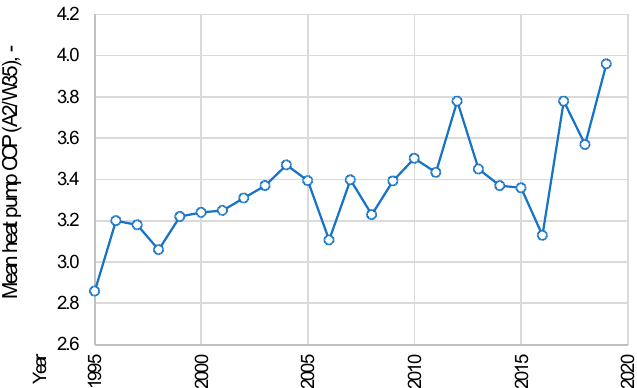
Figure 6. Variability of mean heat pump coefficient of performance (COP) according to EN 255 and EN 14511 in 1995–2019 (own study based on data [22]).